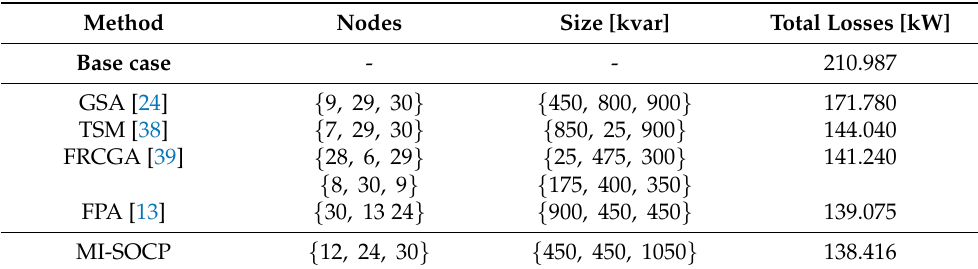
Table 3. Optimal location of capacitor banks in the IEEE 33-node test